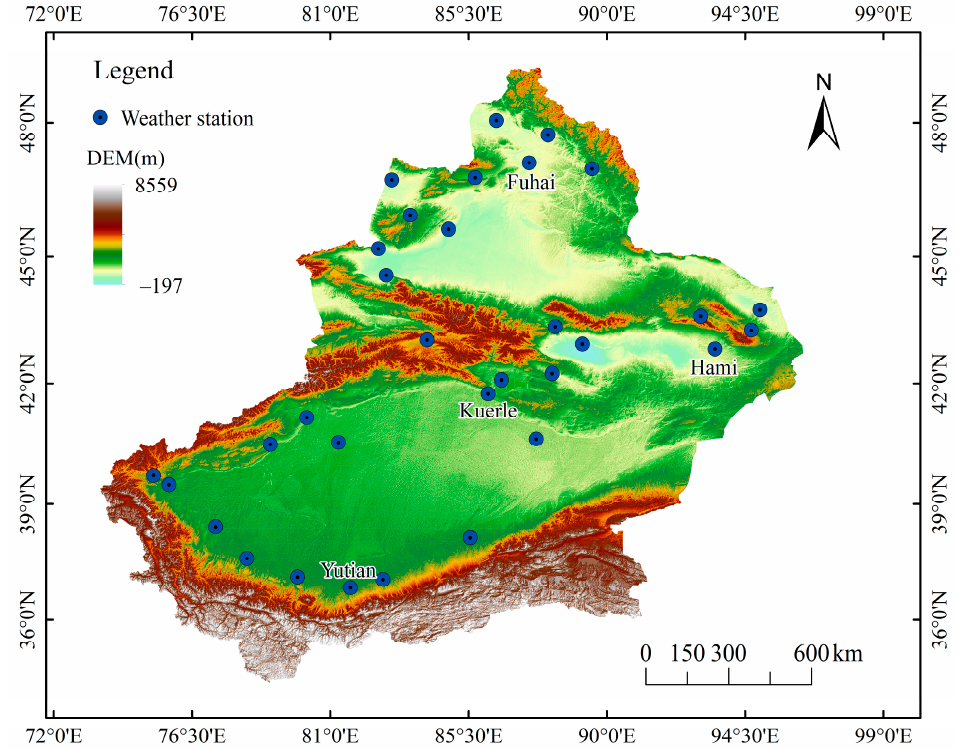
Figure 1. Geographical information and meteorological station distribution in Xinjiang Uygur Autonomous Region. Table 1. Drought classification based on standardized precipitation